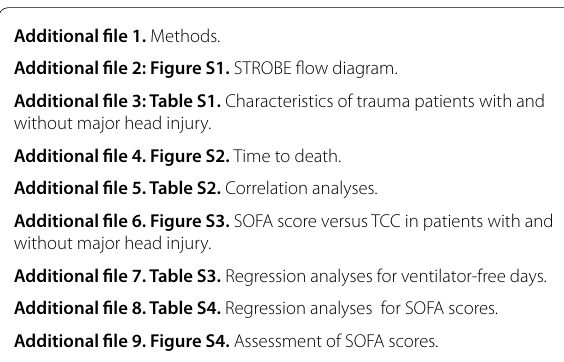
Additional file 6. Figure S3. SOFA score versus TCC in patients with and without major head injury. Additional file 7. Table S3. Regression analyses for ventilator-free days.